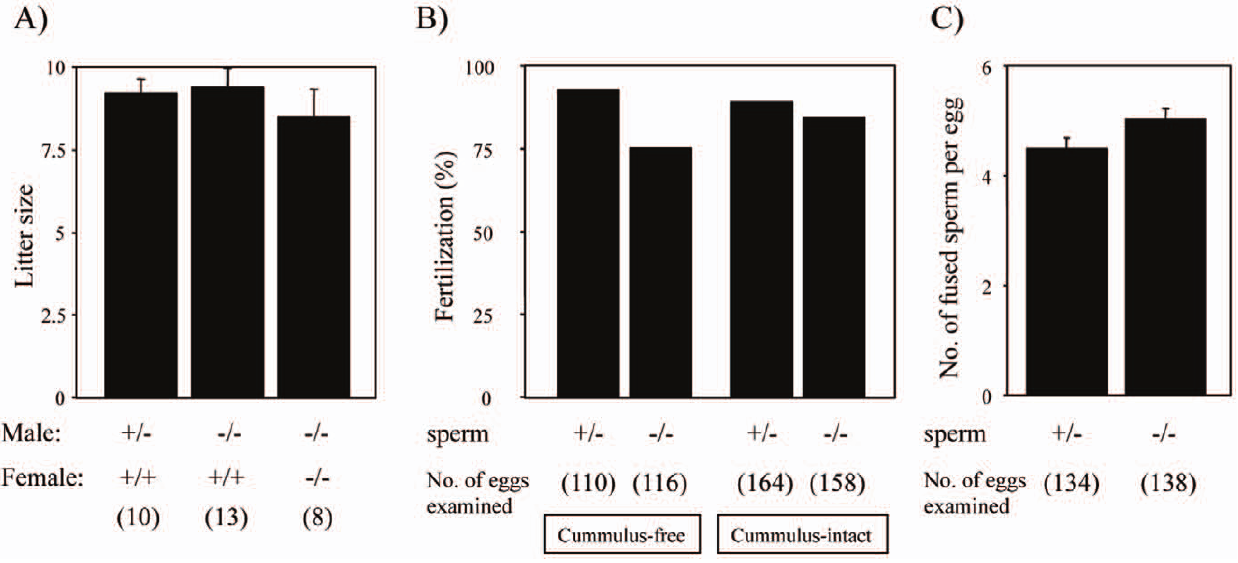
Figure 4. Fertility analysis of Ace3 2 / 2 mice. (A) Fecundity of Ace3 + / 2 and Ace3 2 / 2 males and Ace3 2 / 2 females. The numbers in parentheses indicate the numbers of mating pairs. Values are presented as mean 6 standard error of mean (SEM). (B) in vitro fertilization of sperm from Ace3 + / 2 and Ace3 2 / 2 mice using cumulus-free and –intact eggs (n=5). (C) Comparison of the fusing ability of Ace3 + / 2 and Ace3 2 / 2 sperm. Average numbers of fused sperm observed 30 minutes after insemination (n=5). Values are presented as mean 6 SEM.